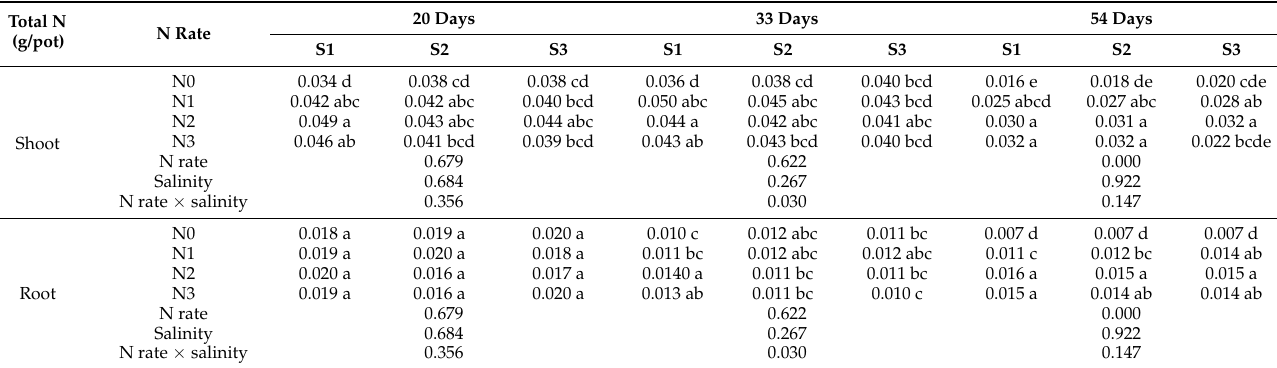
Table 6. Total N of shoot and root in different growth stages of winter